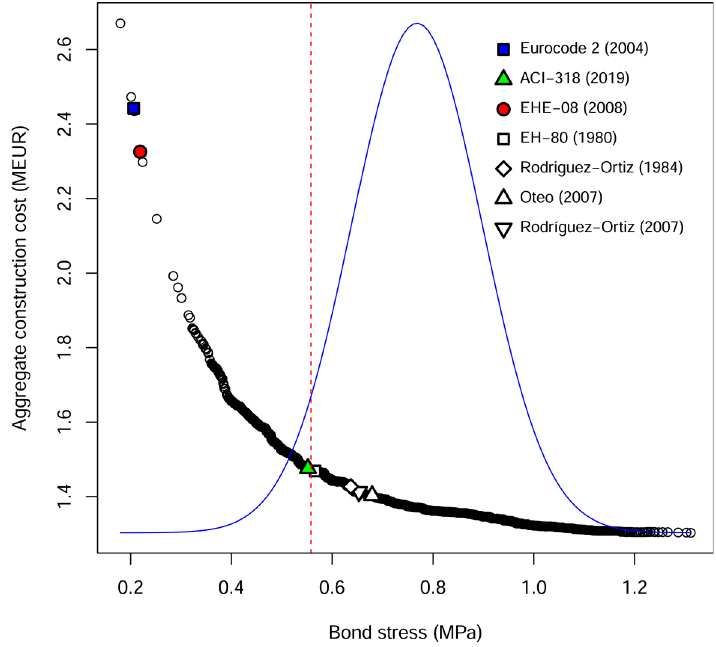
Figure 5. Cost variation plotted against the distribution of bond stress value: Eurocode 2 (2004) [20], ACI-318 (2019) [14], EHE-08 (2008) [22], EH-80 (1980) [24], Rodríguez-Ortíz (1984) [25], Oteo (2007) [26], Rodríguez-Ortíz (2007) [27].